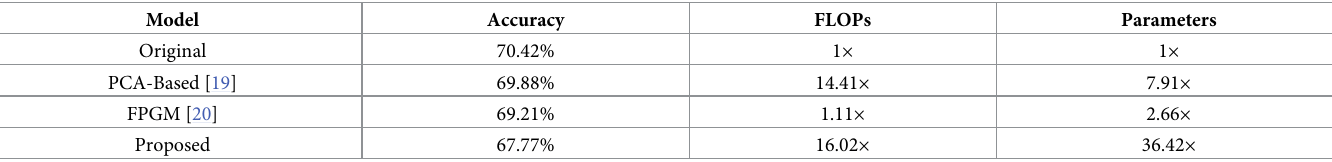
Table 8. Comparison of VGG-19 on CIFAR-100.